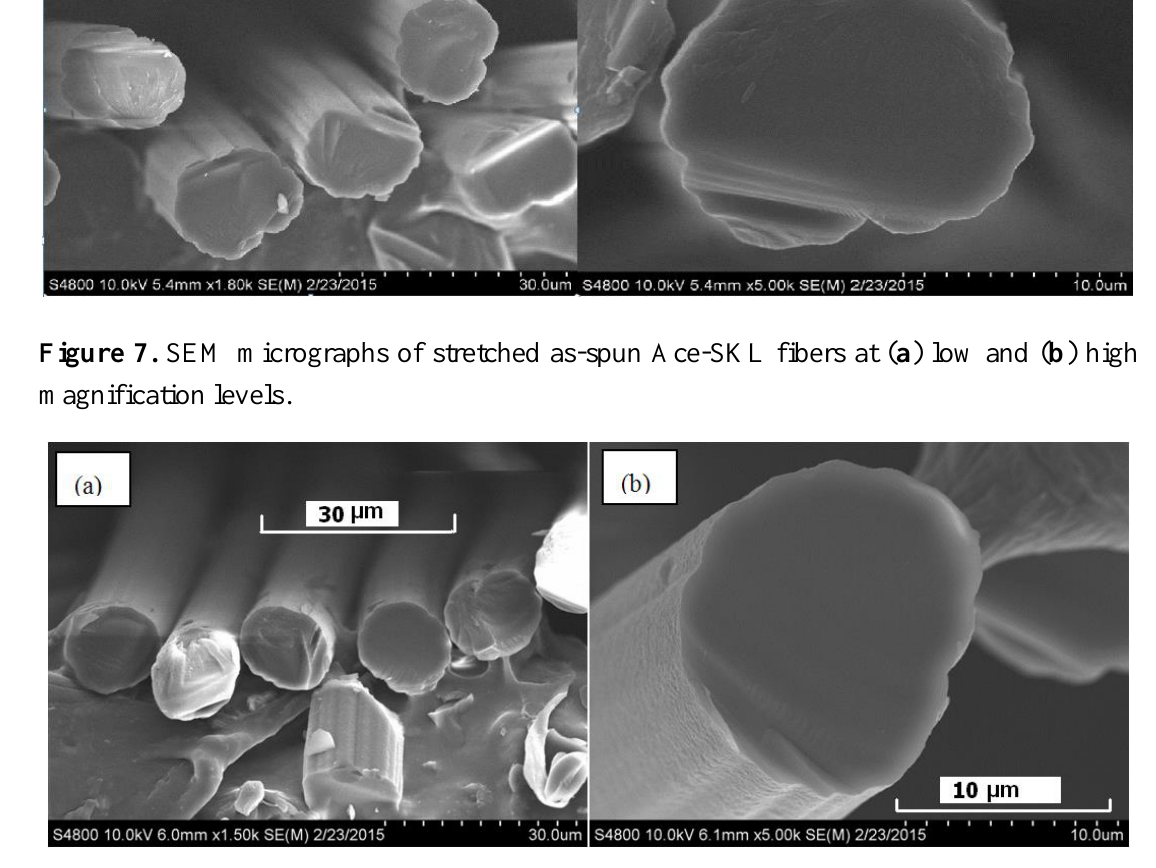
Figure 8. SEM images of UV-treated Ace-SKL fibers at ( a ) low and ( b ) high magnification